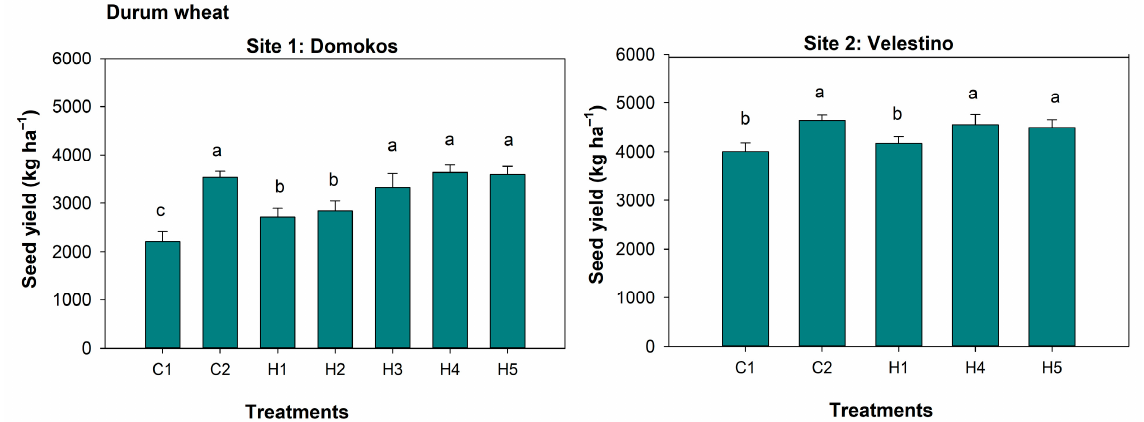
Figure 10. Herbicide treatment (C1: untreated control, C2: weed-free control, H1: metsulfuron-methyl + bensulfuron-methyl, H2: pyroxsulam/florasulam + 2,4-D, H3: aminopyralid + florasulam, H4: bromoxynil + 2,4-D, and H5: halauxifen-methyl + florasulam) effects on seed yield (kg ha − 1 ) at two sites. Values are presented as means of three replicates ± standard deviation. Mean values followed by different letters have statistically significant differences according to Duncan’s multiple range test at p < 0.05. F values of ANOVA: F = 22.340 *** (Site 1: Domokos) and F = 9.156 ** (Site 2: Velestino). ** and *** significant at p < 0.01 and p < 0.001.